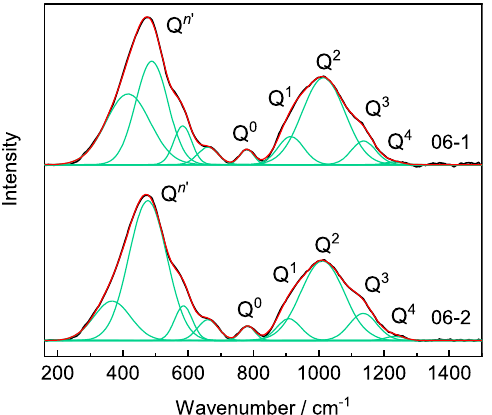
Fig. 3 Raman spectra of the glaze surface of sample No. 06. 06-1 and 06-2 were tested inside and outside the pits, respectively. The black, green, and red lines represent the original Raman spectral curve, the components of spectral curve, and the fi tted spectral curve, respectively. Q n ( n = 0, 1, 2, 3, 4) and Q n' correspond to the streching and bending vibrational modes of the Si-O bond of the SiO 4 tetrahedron.